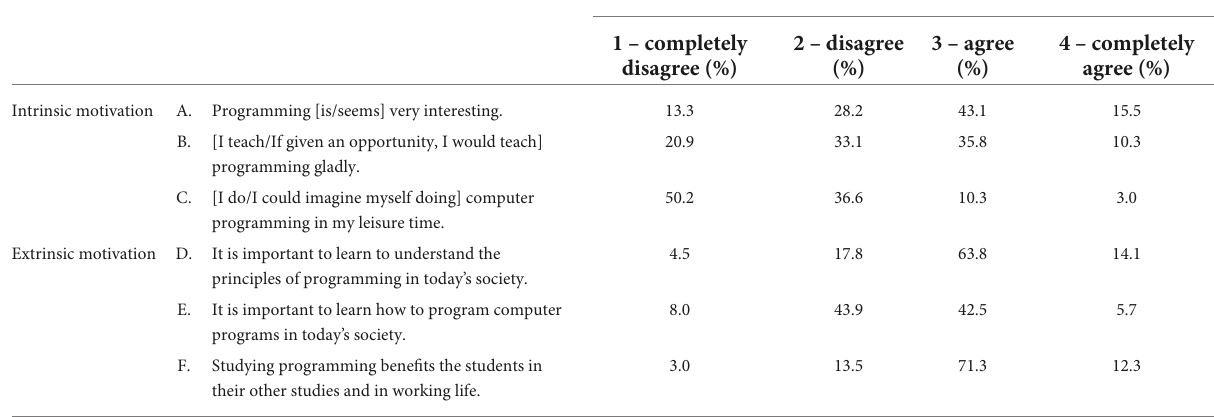
TABLE 5 Descriptive statistics of teachers’ programming motivation. Subscale